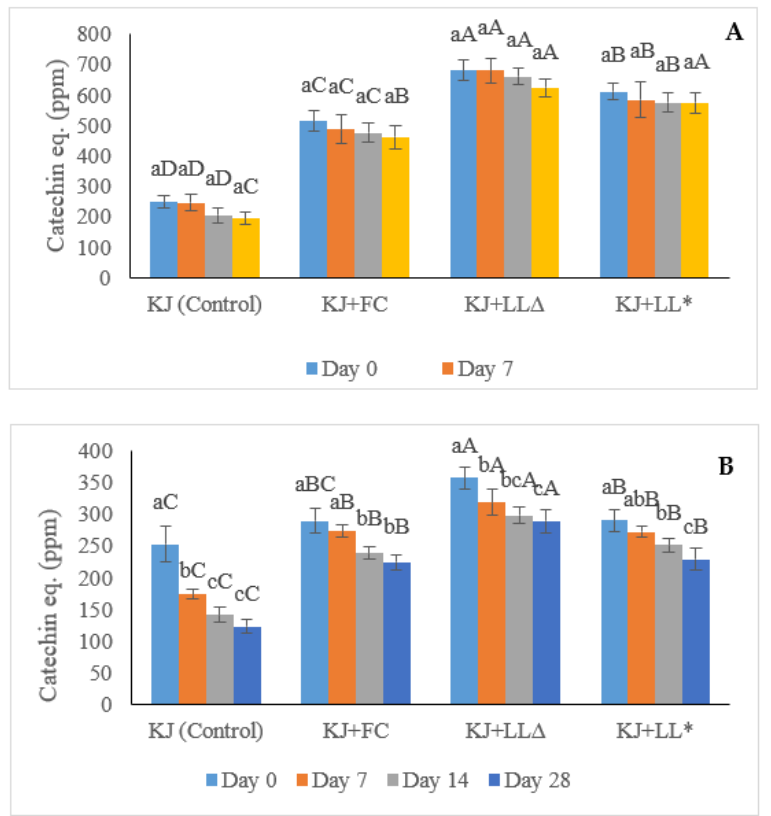
Figure 4. DPPH (2,2-diphenyl-1-picryl-hydrazyl) antioxidant activity ( A ) and total phenolic content (TPC) ( B ) of kiwifruit juices during 28 days of storage, expressed as catechin equivalent (ppm). KJ: control kiwifruit juice; KJ + FC: kiwifruit juice containing free green tea waste extract (GTWE); KJ + LL ∆ : unpasteurised kiwifruit juice enriched with GTWE-loaded single layer liposomes (SLLs); KJ + LL: pasteurised kiwifruit juice containing GTWE-loaded SLLs. Different lowercase letters indicate significant ( p < 0.05) differences among the same kiwifruit juice samples for different storage times; different capital letters stand for statistically significant ( p < 0.05) differences among different kiwifruit juice samples on the same storage day.